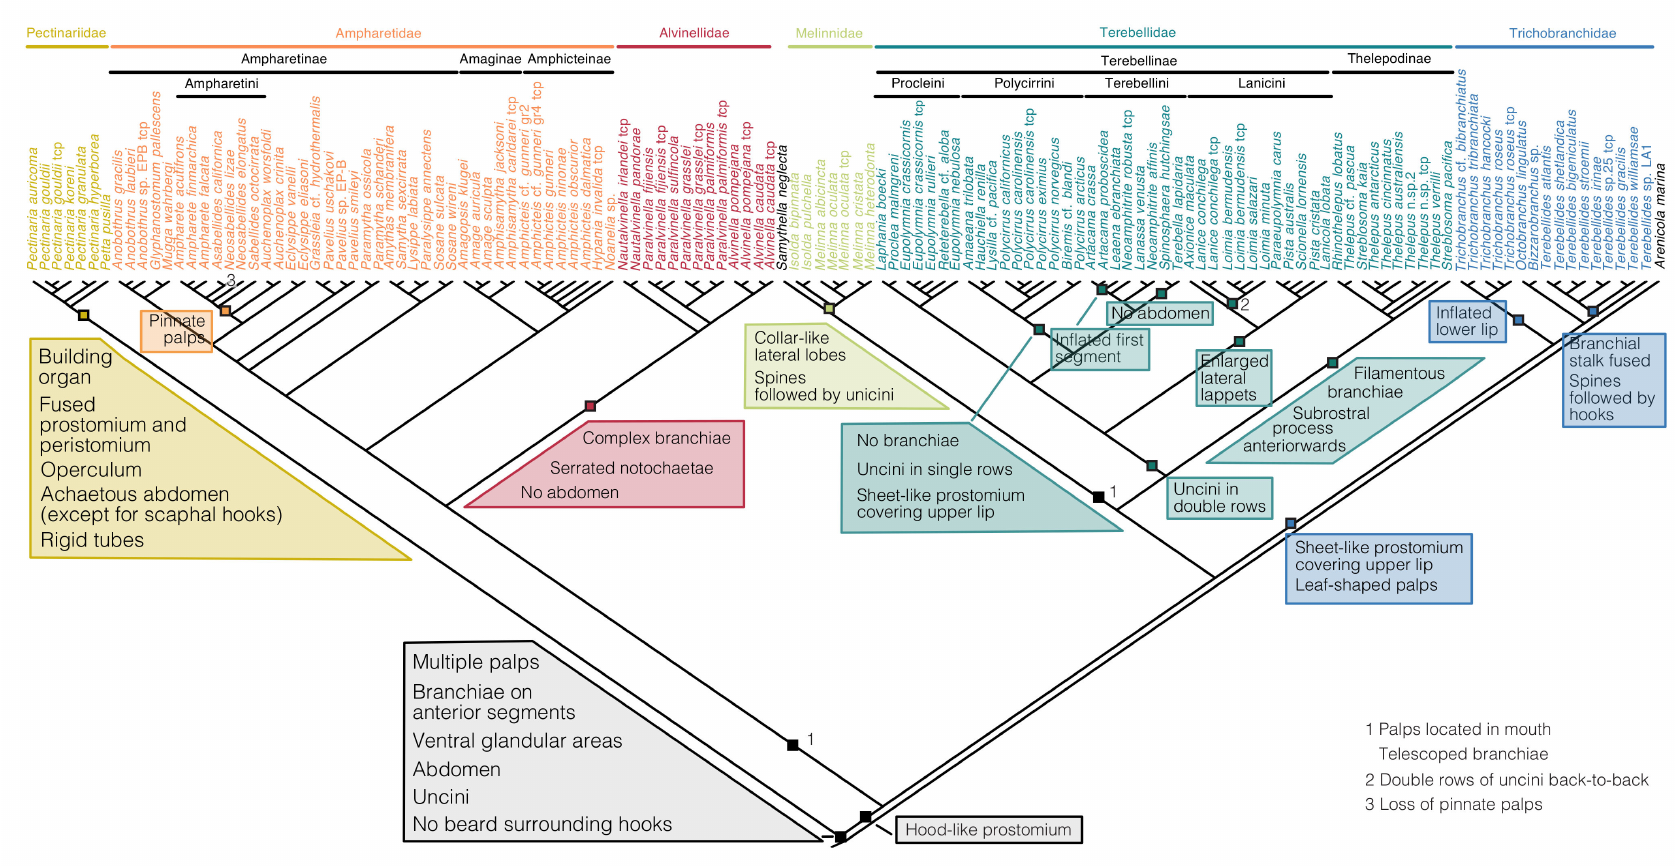
Figure 4. Selected apomorphies of